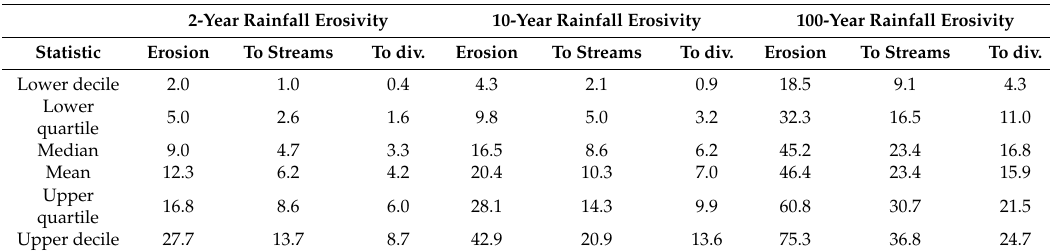
Table 2. Summary statistics of first-year post fire erosion, sediment delivery to streams, and sediment delivery to the water supply diversion (div.) in Mg ha − 1 by rainfall erosivity for the simulated wildfires that burned into the watershed. These are total sediment yields including the coarse and fine fractions. 2-Year Rainfall Erosivity 10-Year Rainfall Erosivity 100-Year Rainfall